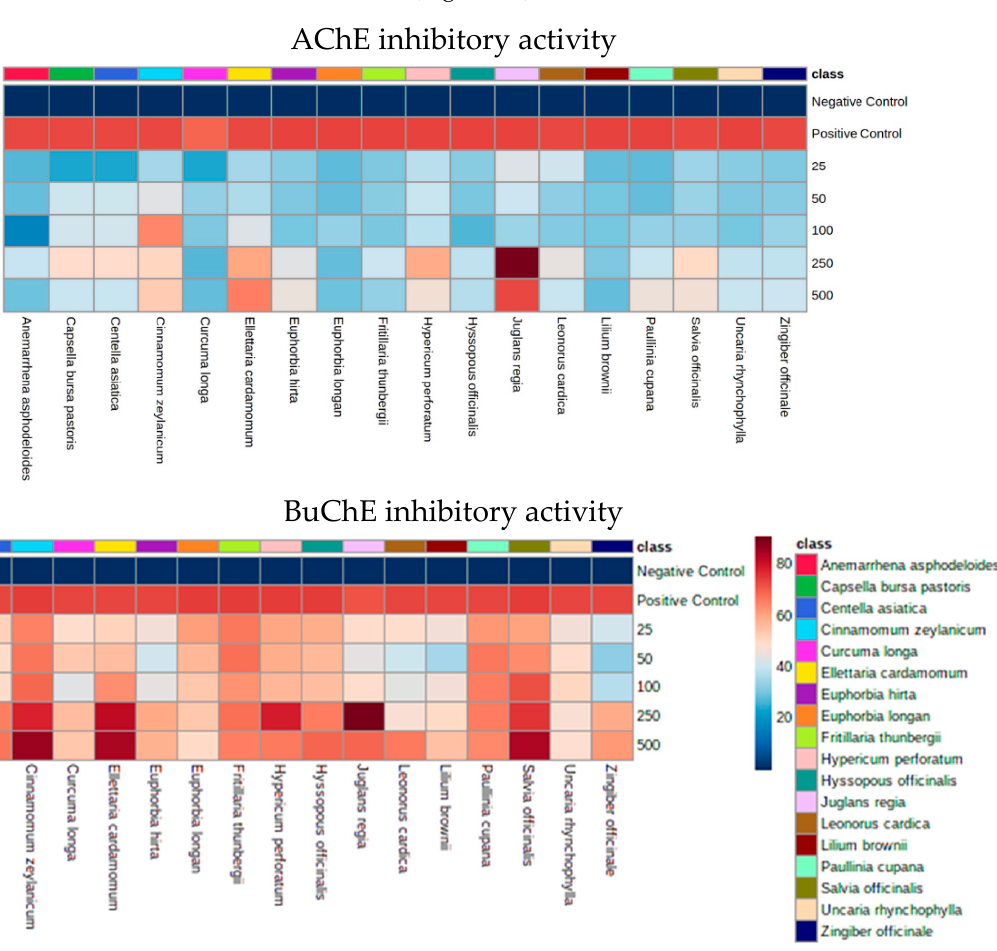
Figure 1. Concentration-dependent effects of plant extracts on acetylcholinesterase (AChE) and bu- tyrylcholinesterase (BuChE) and inhibitory activities. A total of 18 plant extracts were screened using both AChE and BuChE inhibitory assays. Di-nitro-thiobenzoate was added to wells of a 96-well plate, followed by either acetylthiocholine iodide (ATCI) or butyrylthiocholine chloride (BTCC) as substrates. Phytoextracts were tested in duplicate at concentrations ranging from 25–500 µ g/mL. Mean percent- age inhibition data is summarised in the heatmaps. Positive control: galantamine (18 µ M in AChE experiments or 2 µ M in BuChE experiments); negative control: sodium phosphate